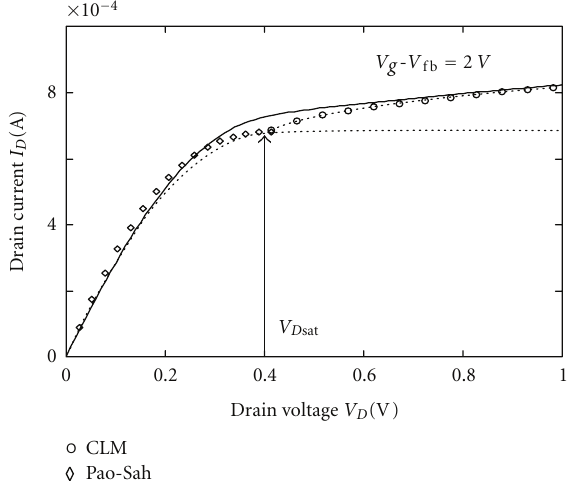
Figure 14: The di ff erent ( I D , V D ) plots with CLM. ( L = 90nm, W/L =